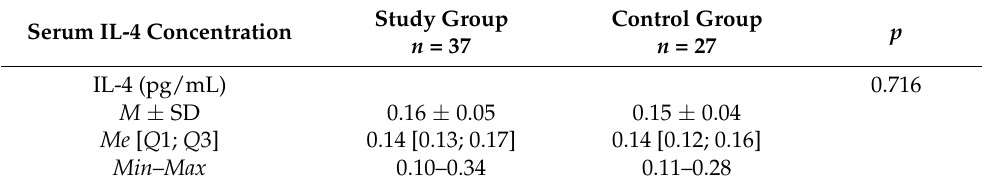
Table 4. Serum concentrations of